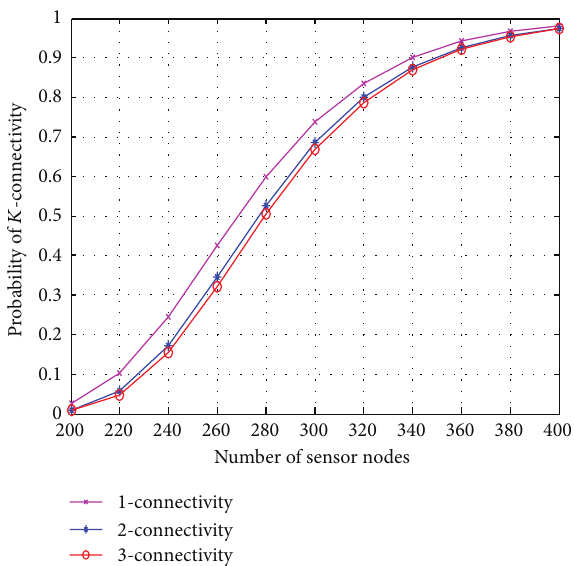
Figure 8: Probability of connectivity versus communication